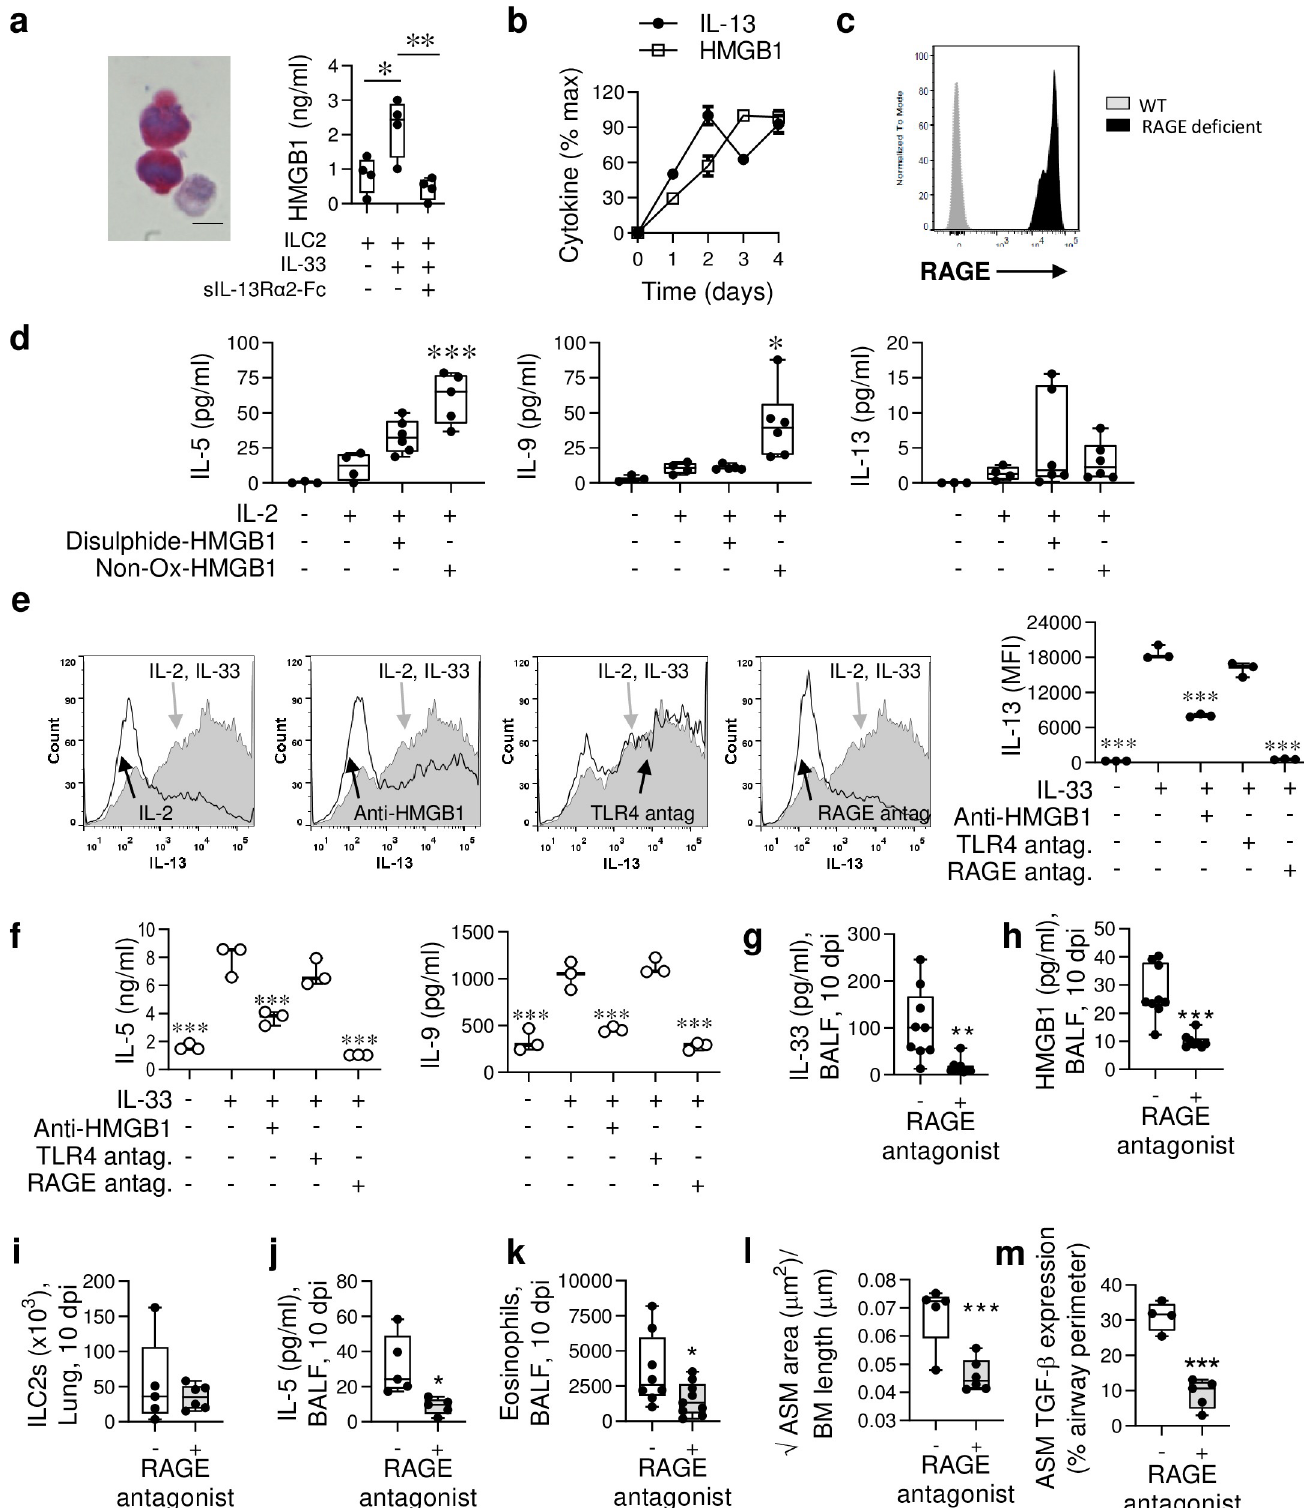
Fig 6. HMGB1/RAGE axis amplifies ILC2 type-2 cytokine production and contributes to ASM growth in vivo . (a [left]) Lung ILC2s were purified from IRF7 -/- mice at 10 dpi and cultured with IL-2 for 4 days. Representative micrograph (x1000 magnification) of HMGB1 expression (red) in IL-33 stimulated ILC2s.